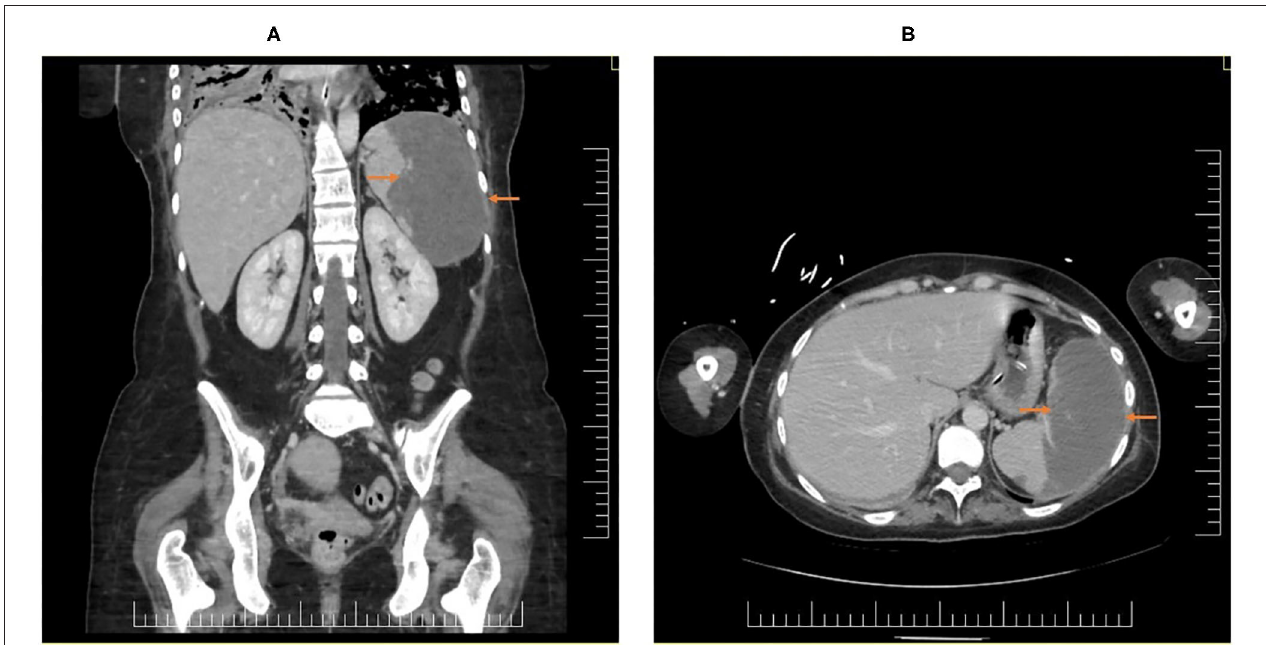
FIGURE 3 | CT scan images showing the splenic infarction, (A) coronal plane and (B) axial